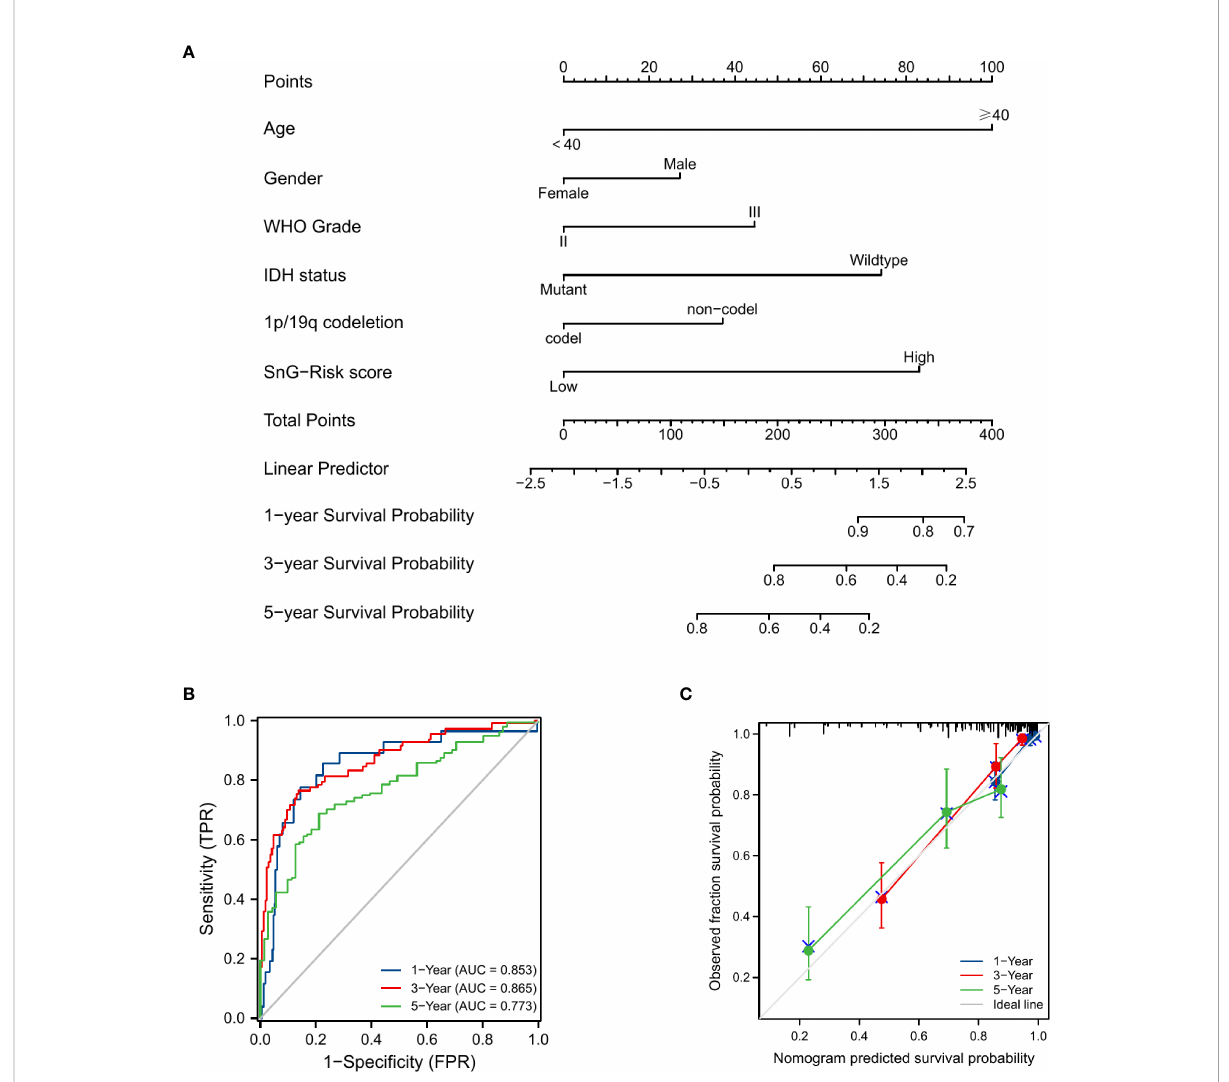
FIGURE 6 Prognosis prediction model for LGG patients. (A) Nomogram for 1-, 3-, and 5-year OS rates. (B) Time-dependent ROC curves of the nomogram. (C) Calibration plots of the